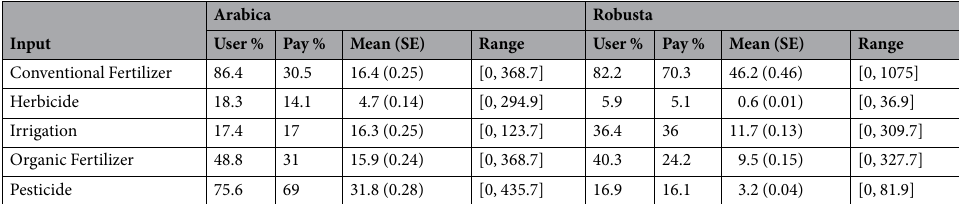
Table 1. Per hectare costs (in 2013 USD) for five major inputs across the two coffee